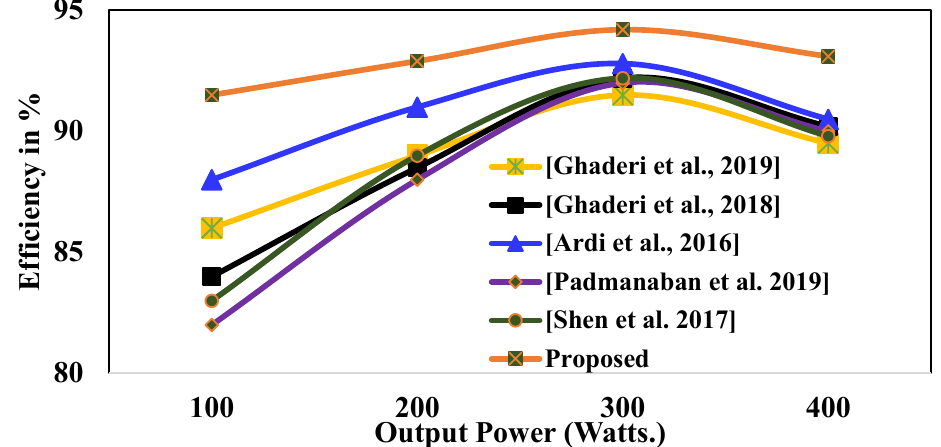
Figure 14. Efficiency curve of different converters.